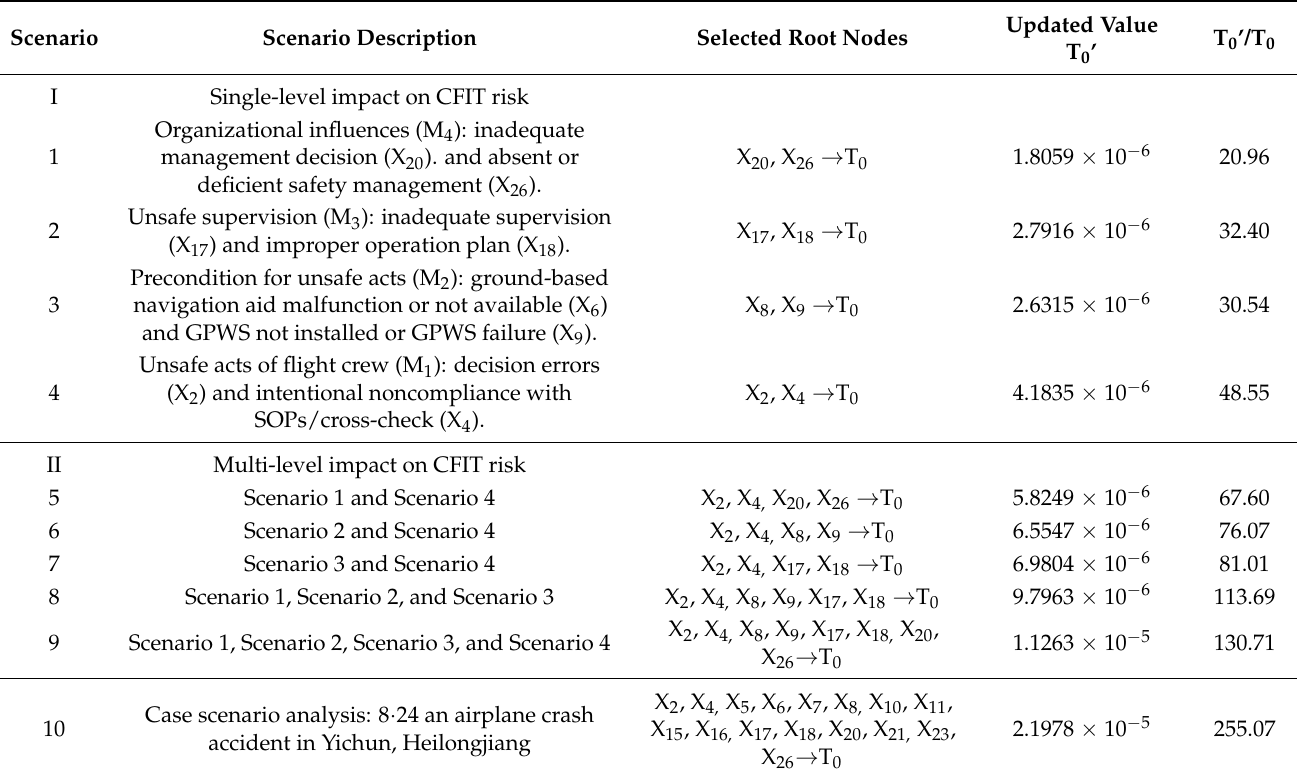
Table 7. Scenario analysis